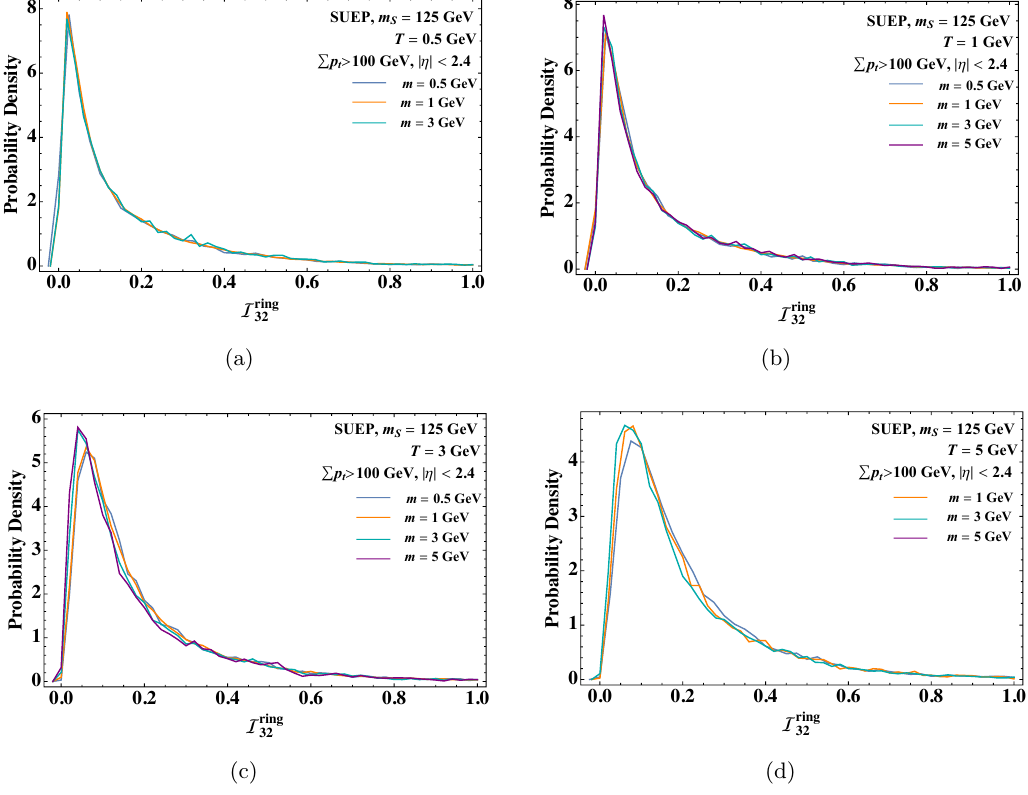
Figure 29 . Distributions of ring-like event isotropy in the SUEP samples for (a) T = 0 : 5 GeV, (b) T = 1 GeV, (c) T = 3 GeV, and (d) T = 5 GeV. The di(cid:11)erent curves on each plot correspond to di(cid:11)erent values of m satisfying m (cid:24) T . For this observable, the dominant behavior is determined by the temperature T with only weak dependence on the lightest meson mass m